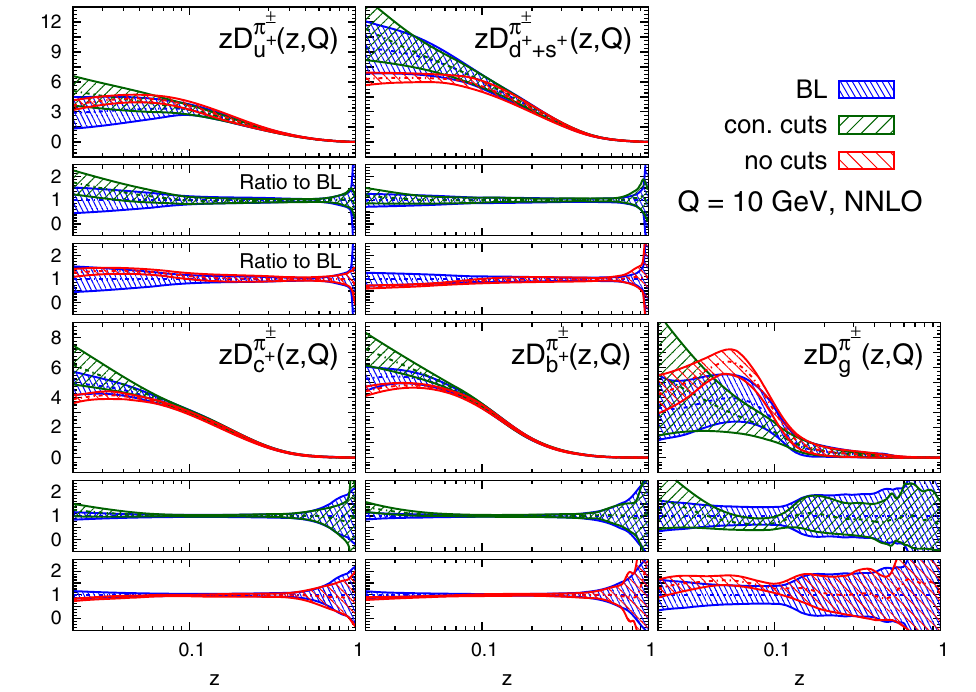
Fig. 17 Comparison among the NNLO charged pion FFs at Q = 10 GeV for three different small- z kinematic cuts: baseline, conservative cuts, and no cuts (see Table 4). The two insets below each distribution show the ratios of the fits with conservative cuts and without cuts to the baseline fit